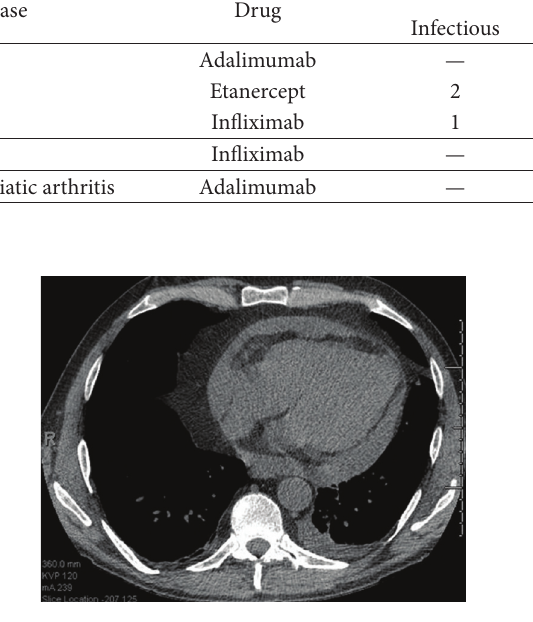
Figure 1: CT of the chest demonstrates a new, moderate, loculated, pericardial effusion and a small left-sided pleural effusion. Right and left atria are normal in